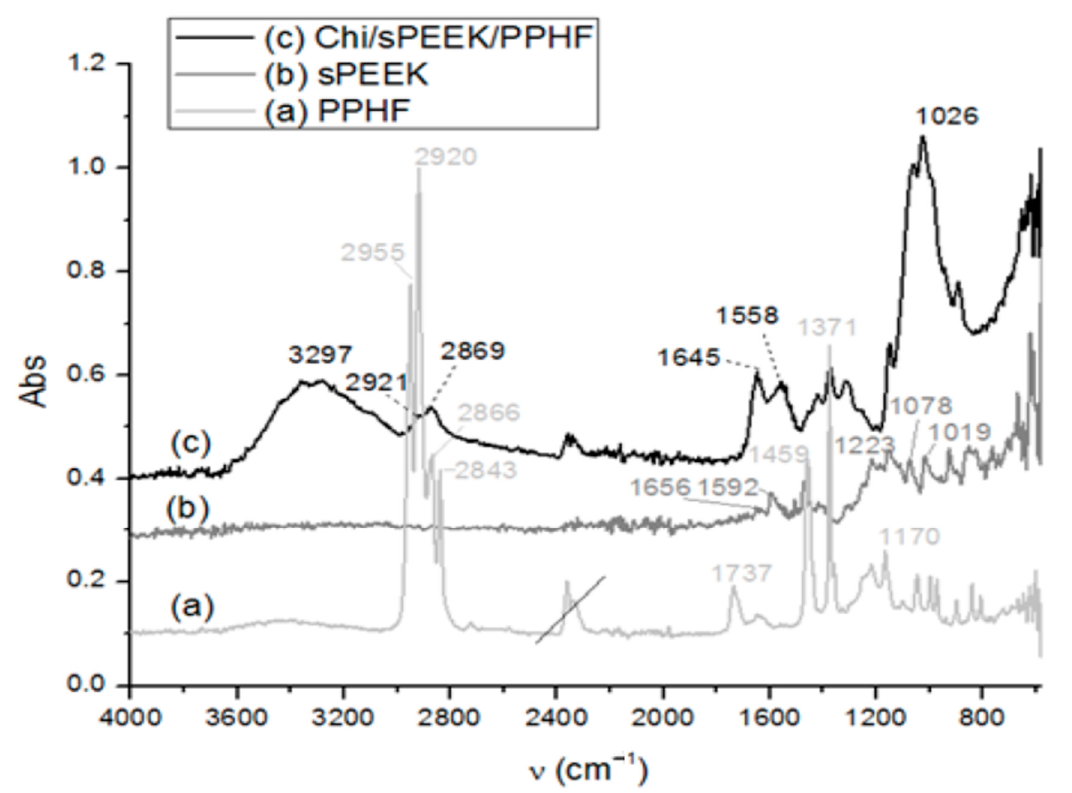
Figure 7. Fourier Transform InfraRed (FTIR) on ( a ) polypropylene hollow-fiber membrane (PPHF); ( b ) sulfonated poly (ether ether ketone) (sPEEK); and ( c ) chitosan (Chi)–sulfonated poly (ether ether ketone) (sPEEK)–polypropylene hollow fiber (Chi/sPEEK/PPHF).